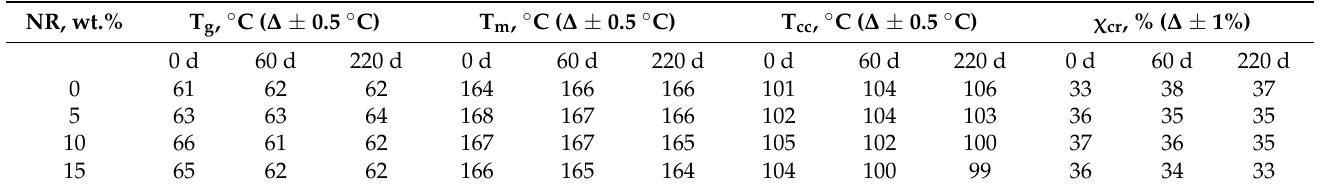
Figure 3. DSC thermograms of initial PLA/NR samples with different NR content, wt.%: 0 (1), 5 (2), 10 (3), 15 (4). Table 1. Thermophysical characteristics of PLA/NR non-woven fiber samples: before and after 60 and 220 days of soil